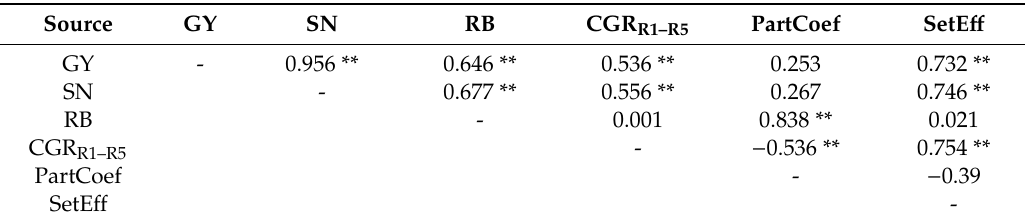
Table 5. Correlation analysis of grain yield and seed number, reproductive biomass, and seeds determined parameters among soybean cultivars under intercropping during